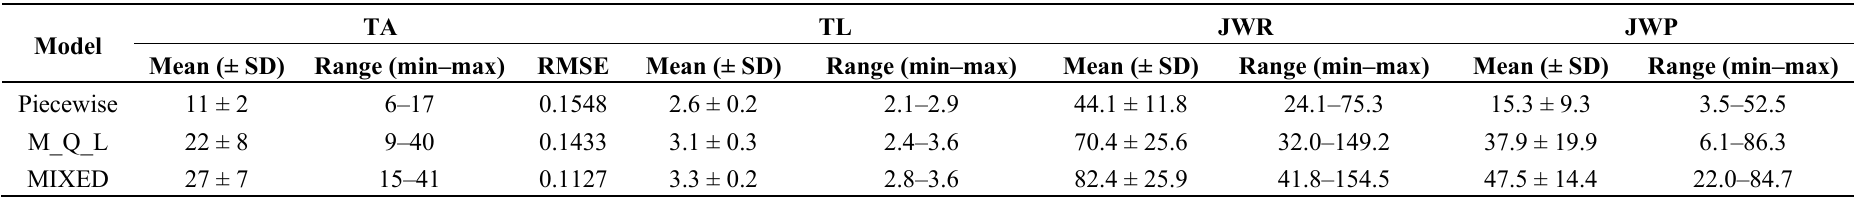
Table 5. Mean, standard deviation (SD), and range for transition age (TA, years), tracheid length at the time of transition (TL, mm), juvenile wood radius (JWR, mm), and juvenile wood proportion (JWP, %) estimated using the three transition age models at breast height (30 trees) with root-mean-squared error (RMSE) as a measure of goodness of fit.